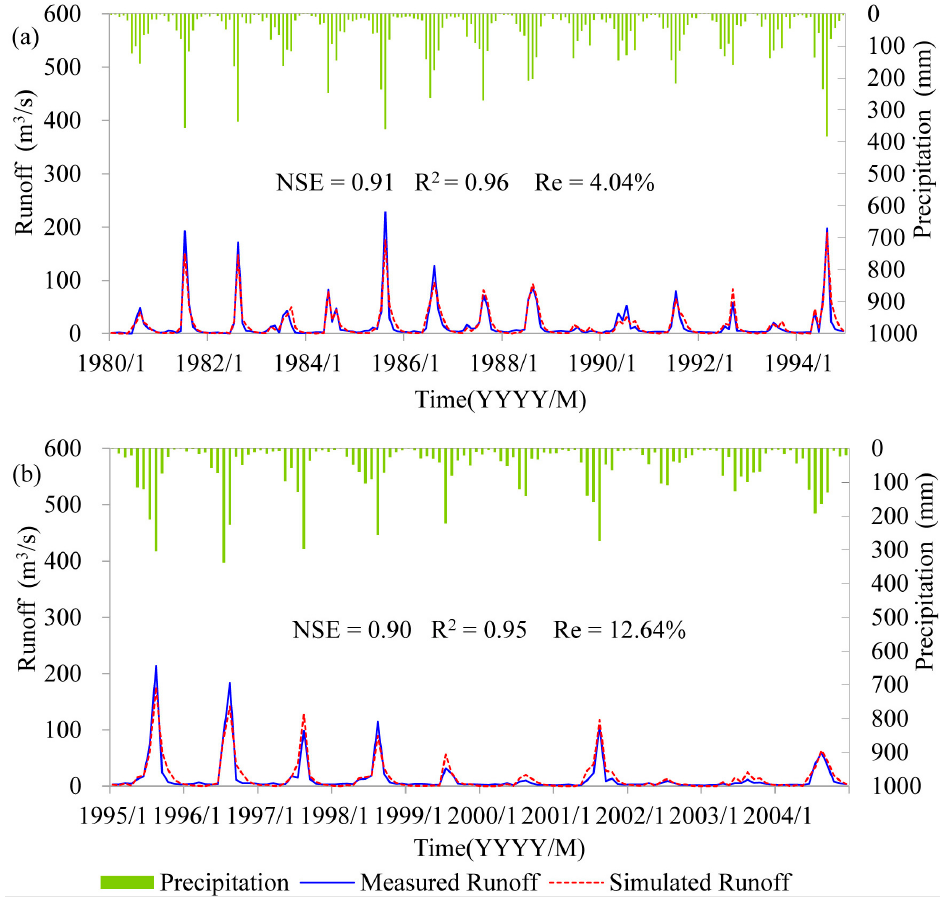
Figure 2. Simulated monthly runoff at Biliu River Reservoir station: ( a ) calibration period of 1980–1989; ( b ) validation period of 1990–1999.